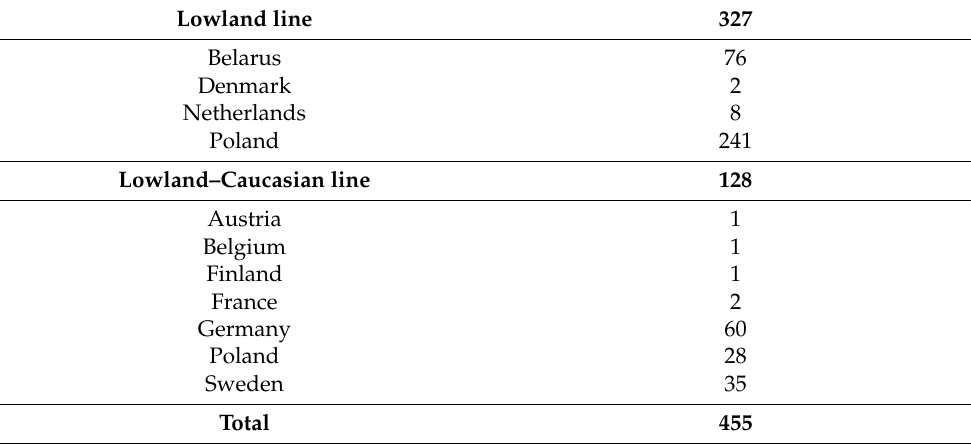
Table 1. Number of wisents and their origins included in the final analysis. Lowland line